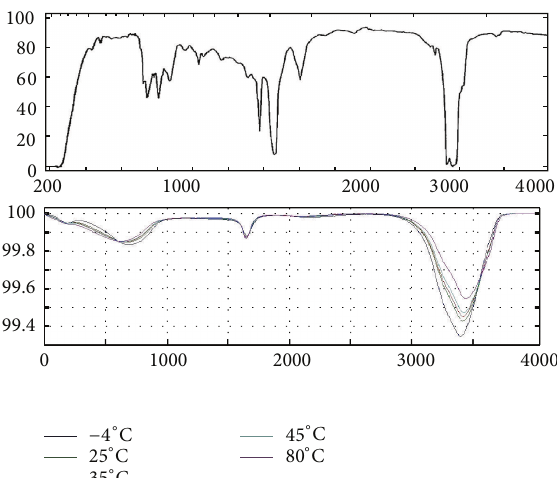
Figure 7: IR spectrum of heavy fuel oil as transmittance spectra [22] and the calculated absorption spectra of ordinary water (for 1- micrometer thick samples).